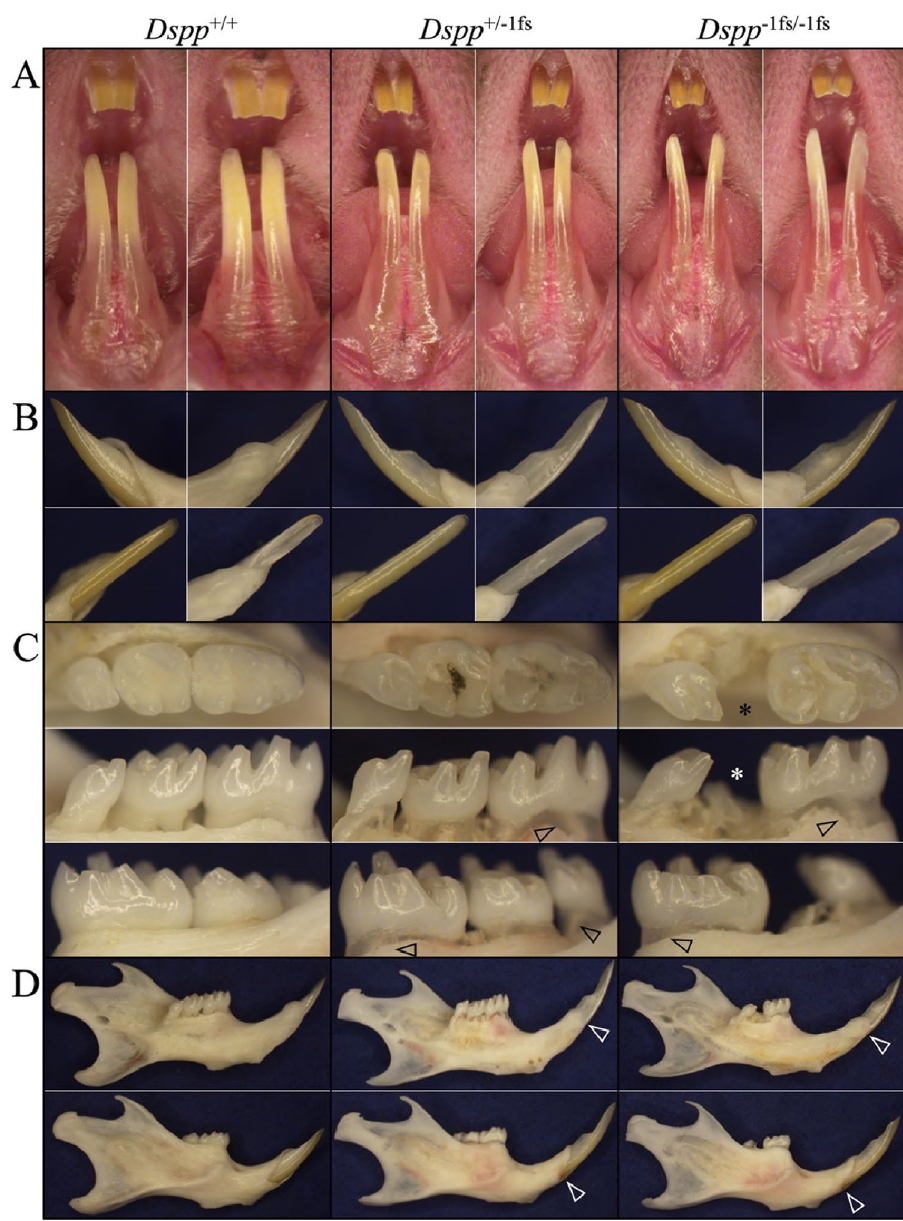
Figure 1. Dissection microscopy photographs comparing 7-week Dspp + / + , Dspp + / −1fs , and Dspp −1fs / −1fs Mice. ( A ) Frontal photos demonstrate that Dspp + / −1fs and Dspp −1fs / −1fs mouse incisors are thinner (mesial-distally) than the wild-type ( Dspp + / + ). The Dspp + / −1fs and Dspp −1fs / −1fs mouse incisors also show an extend apical region of increased translucency much further incisally, apparently due to a reduction or delay in dentin mineralization. ( B ) Close up photographs of the erupted mandibular incisor tip. Clockwise from the upper right: mesial, distal, labial, lingual. Hyper-eruption of the Dspp + / −1fs , and Dspp −1fs / −1fs incisors or diminished alveolar bone causes their longer apparent length outside the bone. ( C ) Occlusal (top), lingual, and buccal (bottom) views of the mandibular molars. Overall enamel crown morphology is normal in the Dspp + / −1fs and Dspp −1fs / −1fs mouse incisors. The root dentin is translucent (arrowheads) and the height of the alveolar crest is lower relative to the cemento-enamel junction in the Dspp + / −1fs , and Dspp −1fs / −1fs molars. ( D ) Lingual (top) and lateral (bottom) views of the mandibles. Increased length of the erupted portion of the incisor beyond the buccal alveolar crest (arrowheads). The mandible is transparent in some areas (showing through the color of the dark blue background), suggesting decreased